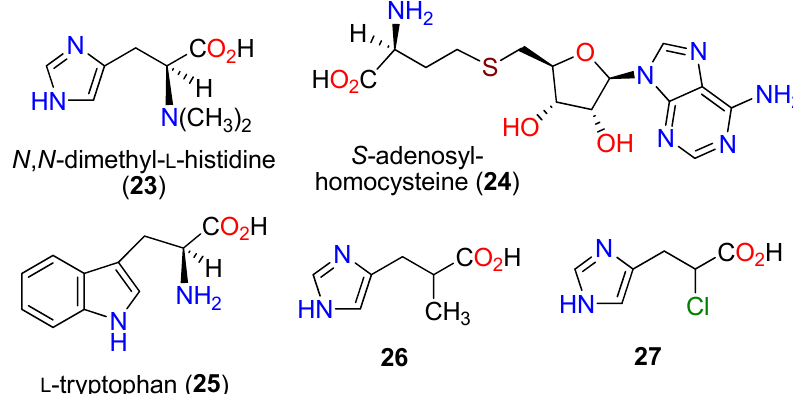
Figure 5. Structures of N , N -dimethyl-L-histidine ( 23 ), S -adenosylhomocysteine ( 24 ), L-tryptophan ( 25 ), 26 , and 27 .